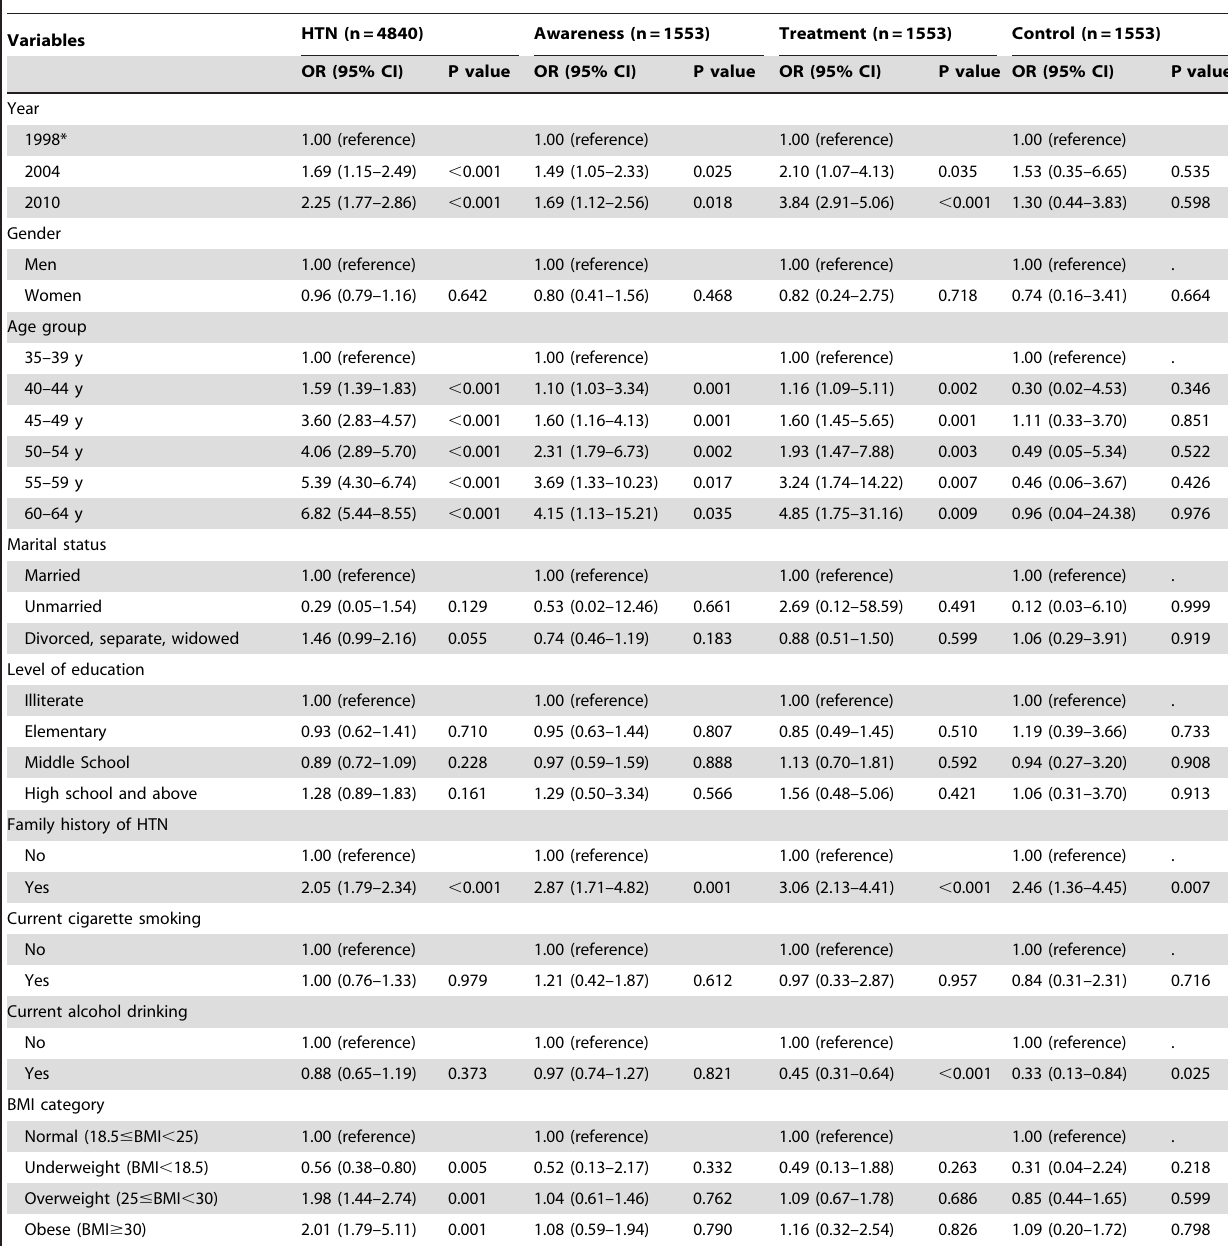
Table 5. Results of logistic regression analyses of risk factors for prevalence, awareness, treatment and control of